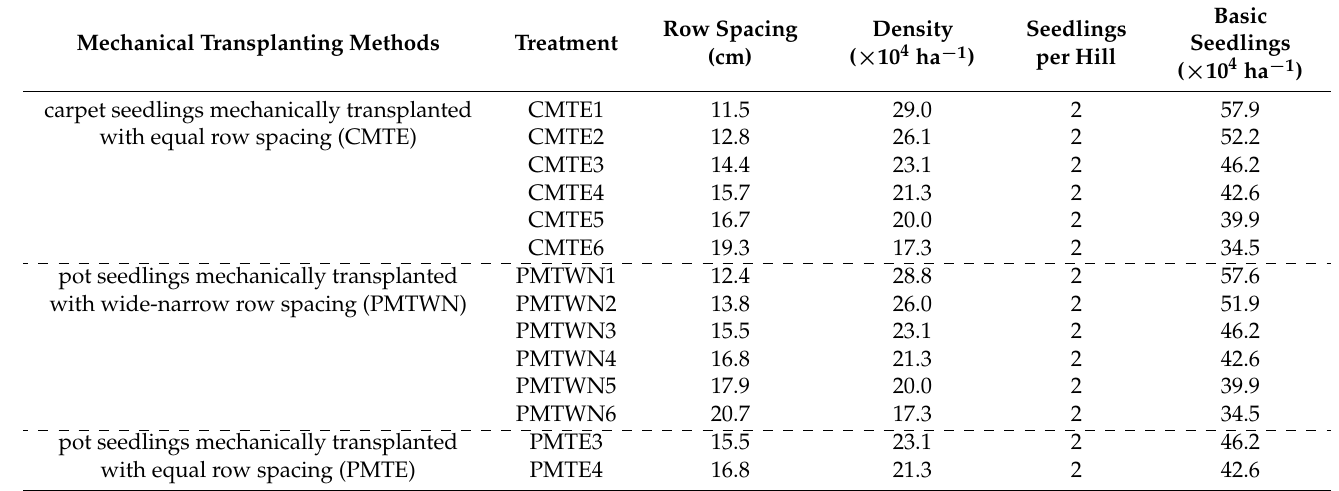
Table 1. Comparison of basic rice seedlings of different mechanical